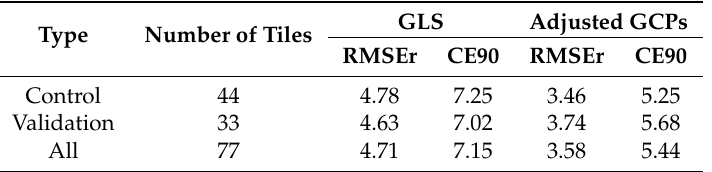
Table 8. Validation results for the Australia block using Image-to-Image characterization between the Sentinel-2 GRI tiles and Landsat 8 Level-1 terrain-corrected (L1T) products that were processed before (GLS) and after (Adjusted GCPs) bundle